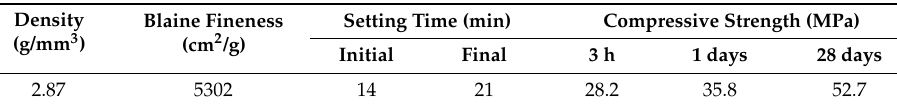
Table 2. Physical properties of rapid-hardening cement.